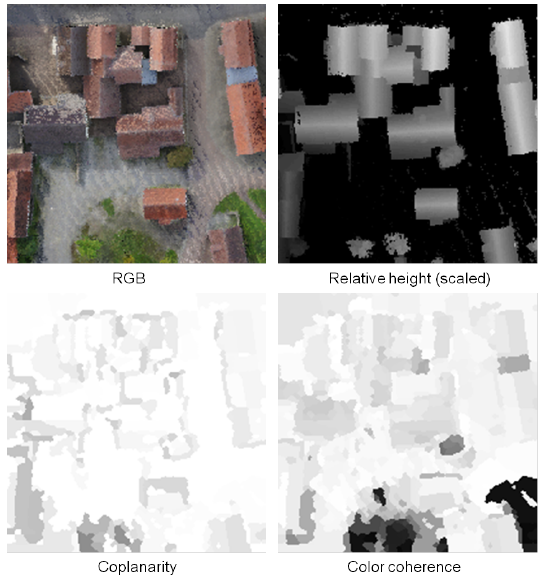
Figure 7. Patches generated by oversegmentation employing color, elevation and normal vector information